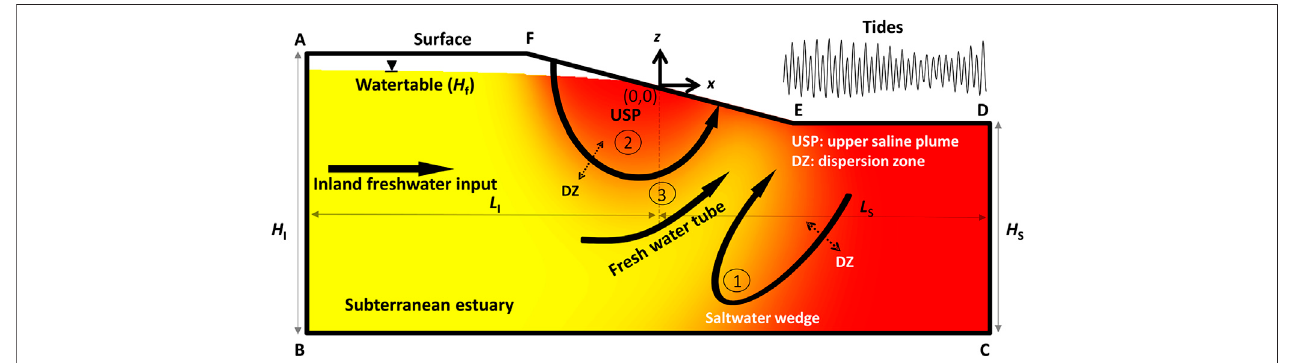
FIGURE 1 | Conceptual diagram of a subterranean estuary of an uncon fi ned aquifer. Flow processes considered in this article are as follows: 1) density-driven seawater circulation, 2) tide-induced seawater circulation, and 3) terrestrial groundwater discharge. The colors represent the salinity (yellow for freshwater and red for saltwater). Boundary ABCDEF represents the model domain. The x-z coordinate origin was set at the mean shoreline. L I and L S are the inland and seaward aquifer extents, respectively. H I and H S are the inland and seaward aquifer thicknesses, respectively. H f is inland watertable elevation at the inland